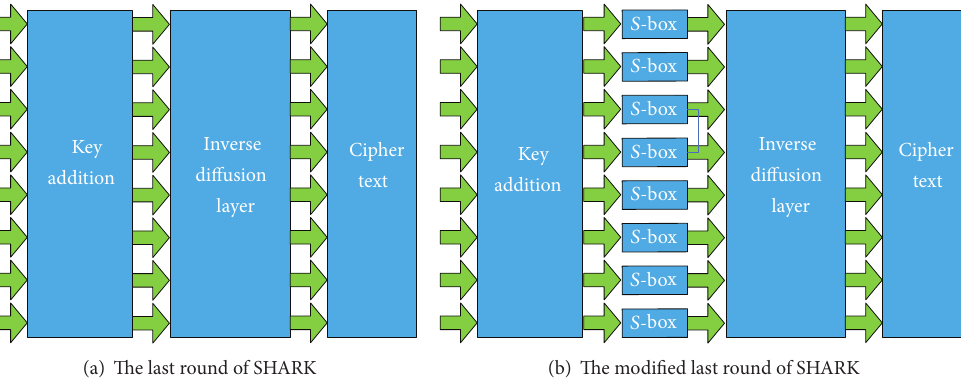
Figure 4: Modification of the last round of